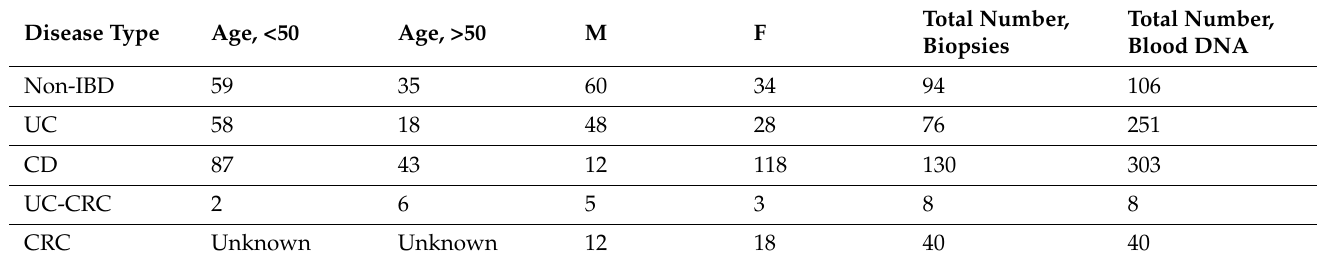
Table 1. Demographics of patients in this study. Summary of biopsies collected from patients recruited for this study. Inclusion criteria for IBD patients were CD, UC, UC-CRC, or CRC. Non-IBD excluded IBS, celiac, or GERD patients. Exclusion criteria were patients with no co-morbidities unless for UC-CRC. Of those recruited, 40–50 were used for detailed biomarker analysis, unless otherwise stated. Selection was based on yield and purity for specific assays.